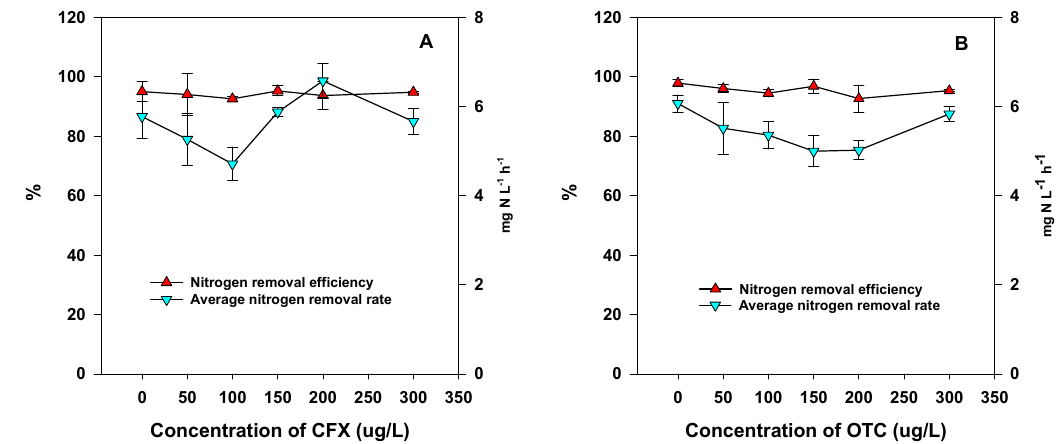
Figure 1. Aerobic denitrification performance in the presence of CFX ( A ) and OTC ( B ).